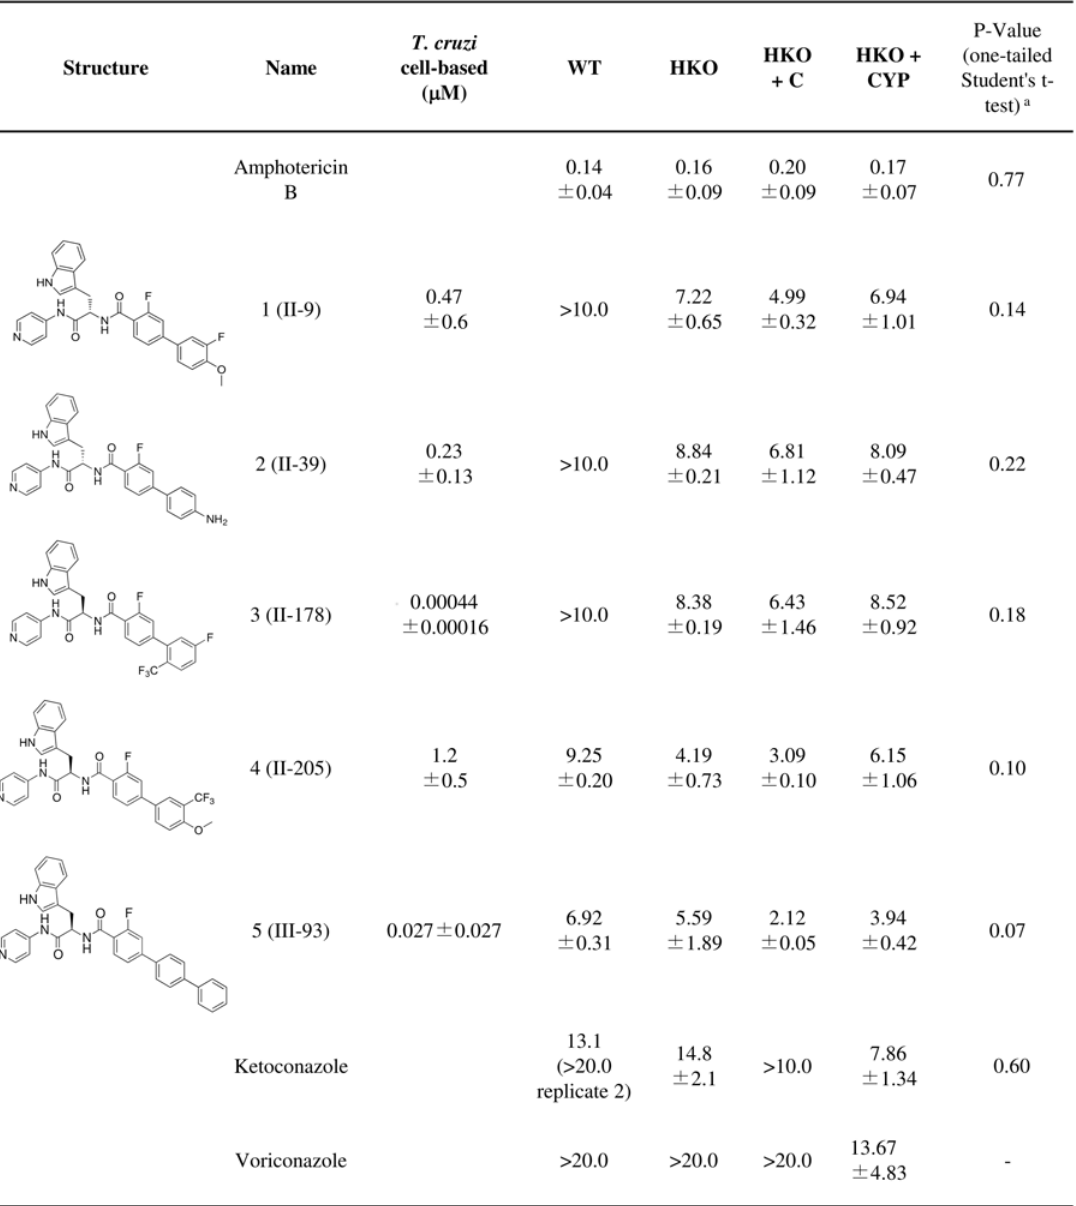
Fig 3. Susceptibility of half knockout strains to CYP51 inhibitors (EC50, μ M): compounds with no significant differences between HKO + C and HKO + CYP strains. Values ± standard error are shown. a p-values are for comparison between HKO+C and